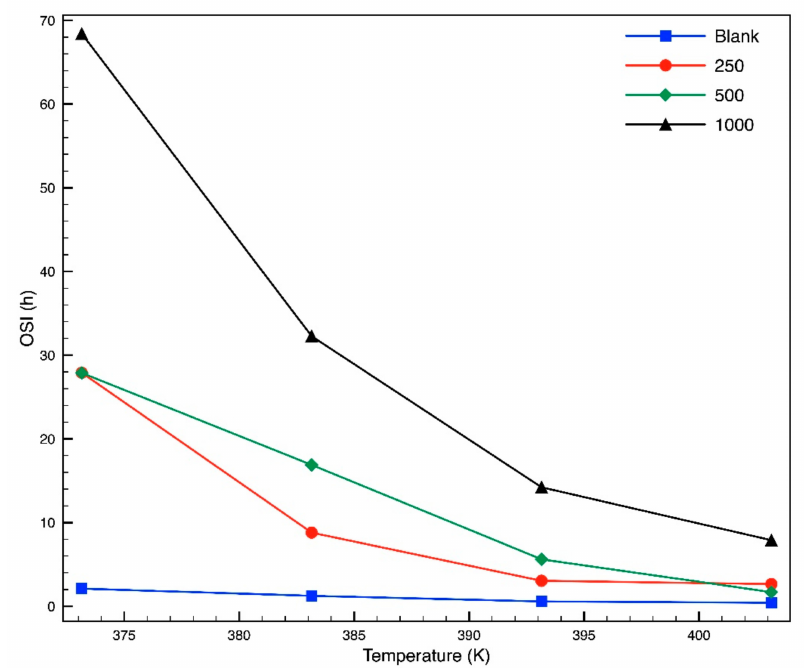
Figure 6. Oxidative stability index (OSI) at di ff erent temperatures and several di ff erent concentrations of L. tridentata